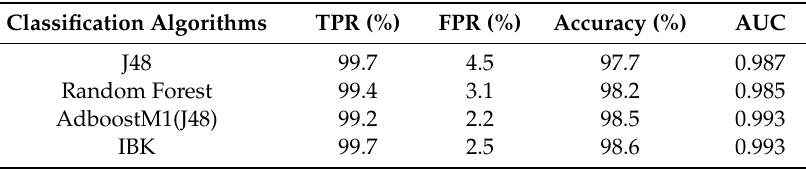
Table 6. Experimental results for four classification algorithms.